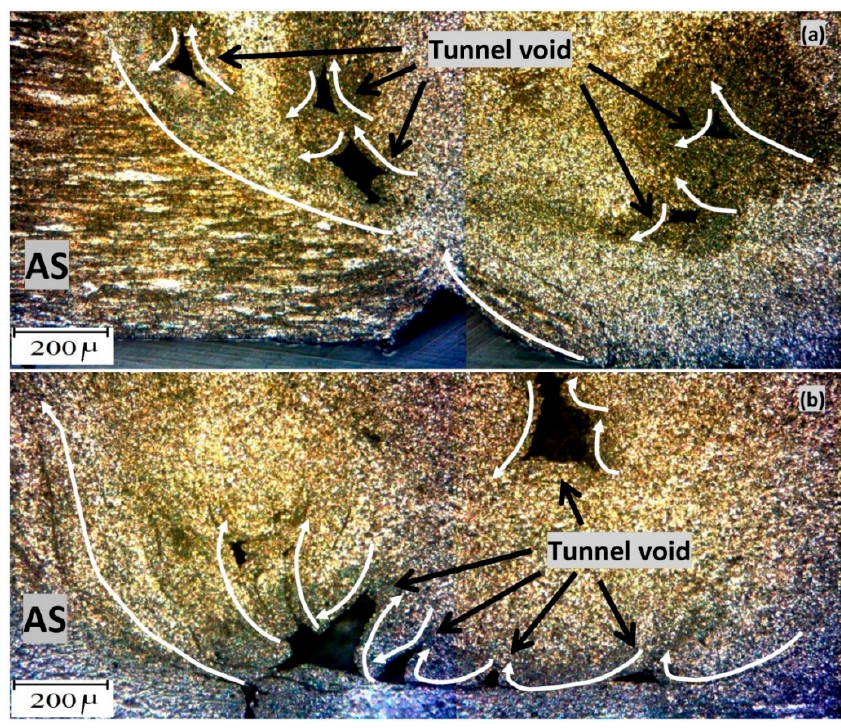
Figure 9. Micro-void features visible in stirring zone of the FSW weld, known as a tunnel void, observed in: ( a ) conical tool and ( b ) square tool welds.